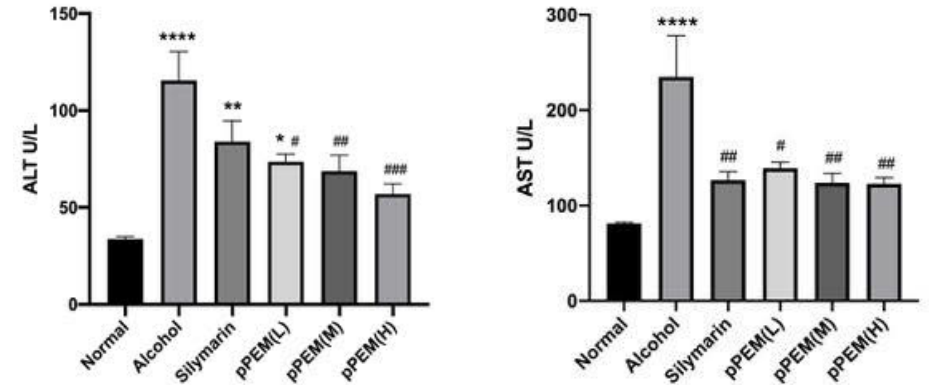
Table 2. Effects of pPEM on several serum biochemistry values in alcohol-treated rats.